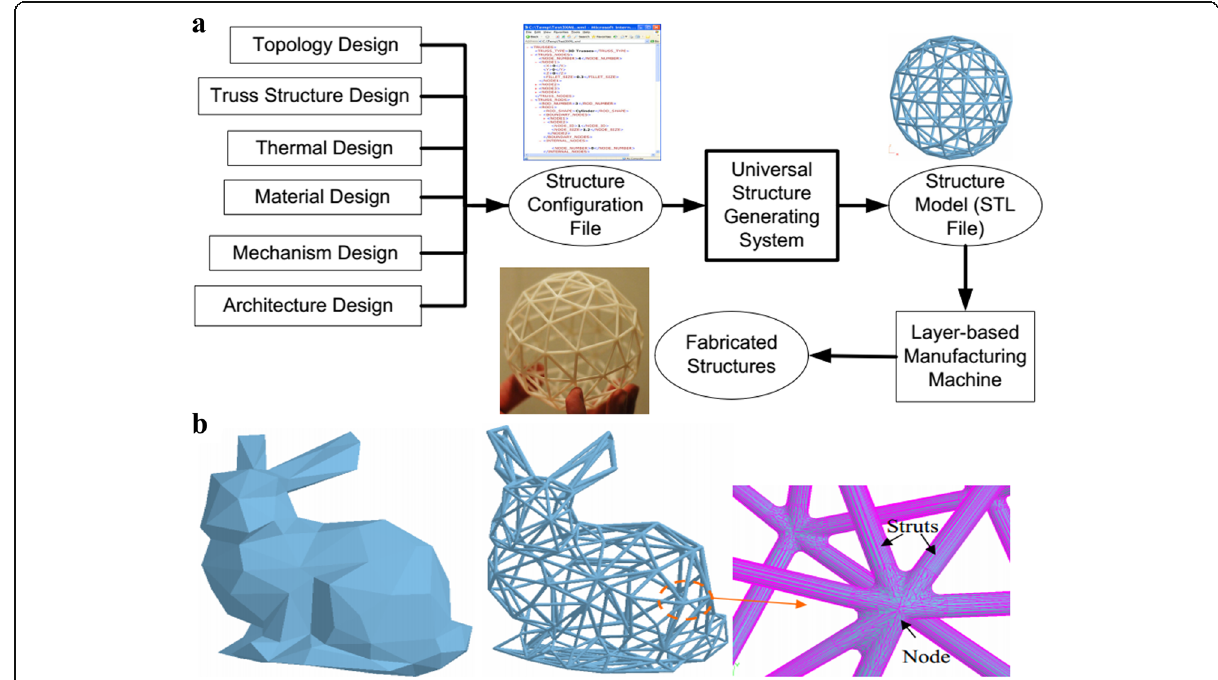
Fig. 20 Lattice design system: a The universal design system. b Design results of lattice structures [12]